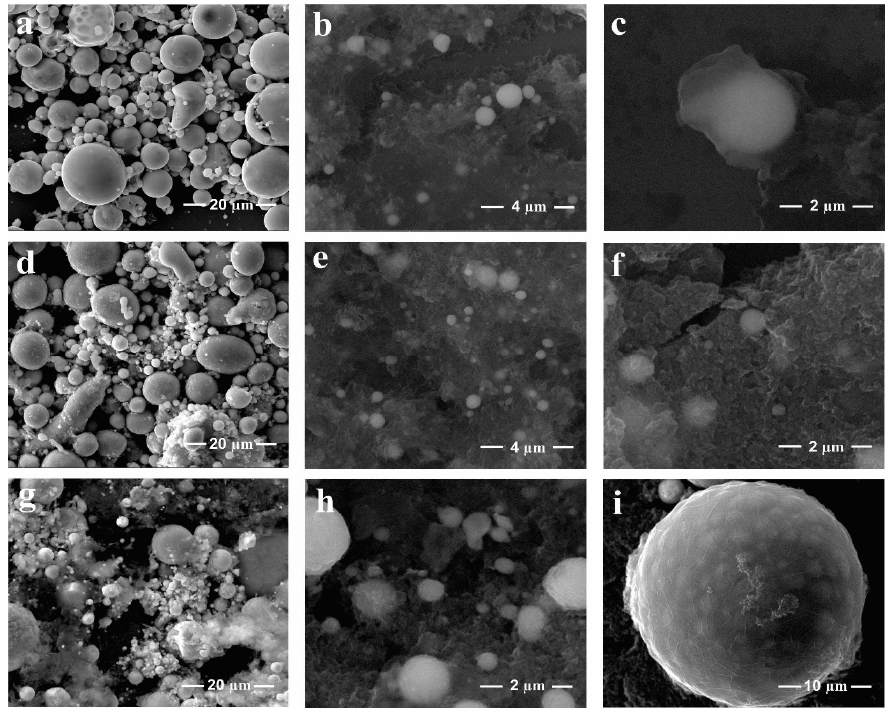
Figure 2. SEM micrographs of nickel particles synthesized in DI water ( a – c ), alcohol ( d – f ) and tolu- ene ( g – i